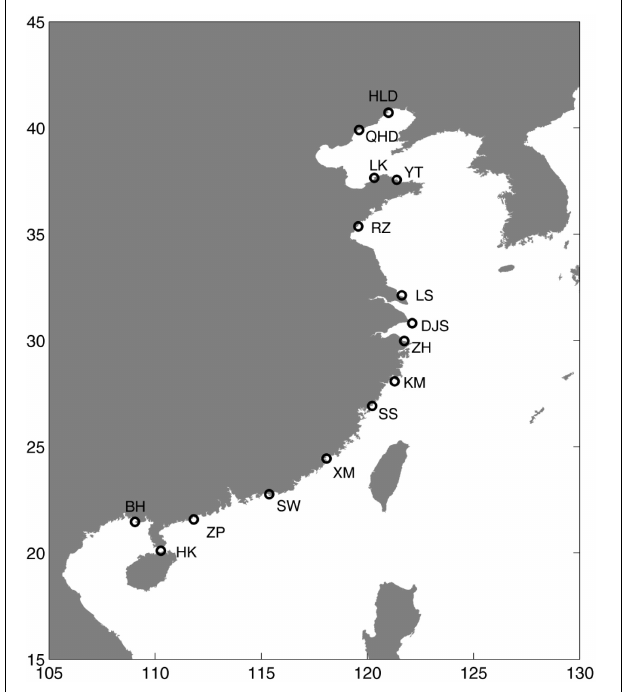
FIGURE 1 | Locations of 15 tide gauges along the coast of China used in this work: HLD, Huludao; QHD, Qinhuangdao; LK, Longkou; YT, Yantai; RZ, Rizhao; LS, Lusi; DJS, Dajishan; ZH, Zhenhai; KM, Kanmen; SS, Shansha; XM, Xiamen; SW, Shanwei; ZP, Zhapo; HK, Haikou; and BH, Beihai.